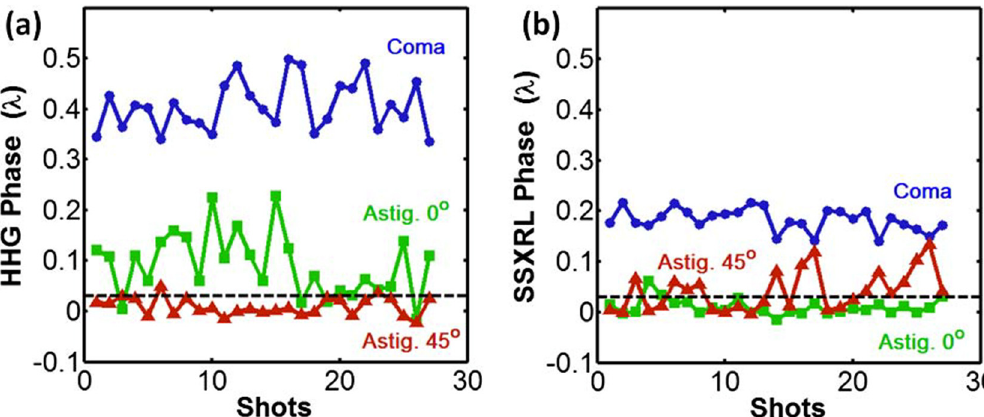
Figure 12. Shot-to-shot stability of the main aberrations for the High Harmonic Generation seed ( a ) and the seeded soft X-ray laser ( b ). Complementing the strong wavefront improvement, the wavefront is much more stable after amplification (reprint with permission from [21] © The Optical Society).